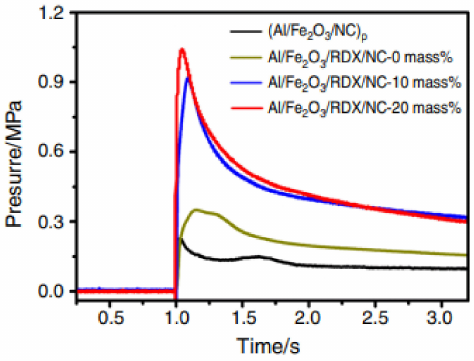
Figure 5-7. Temporal pressure rise curves during the reaction of (Al/Fe 2 O 3 /NC) p composites pre- pared by simple physical mixing and Al/Fe 2 O 3 /RDX/NC composites containing different RDX con- tents prepared by electrospray process. Reproduced with the permission of ref. [151]. Copyright 2019, Journal of Thermal Analysis and Calorimetry.